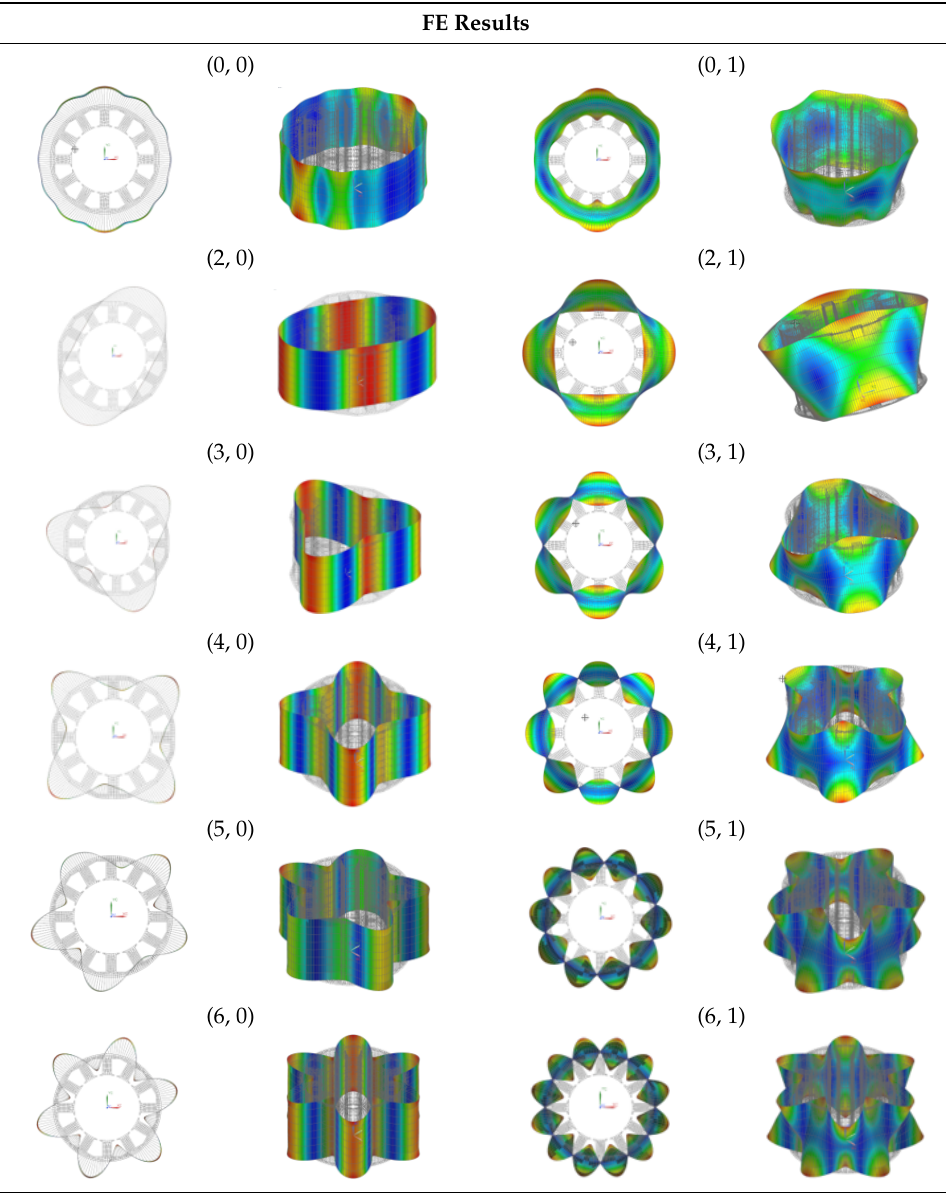
Table 3. Mode-shapes of the stator